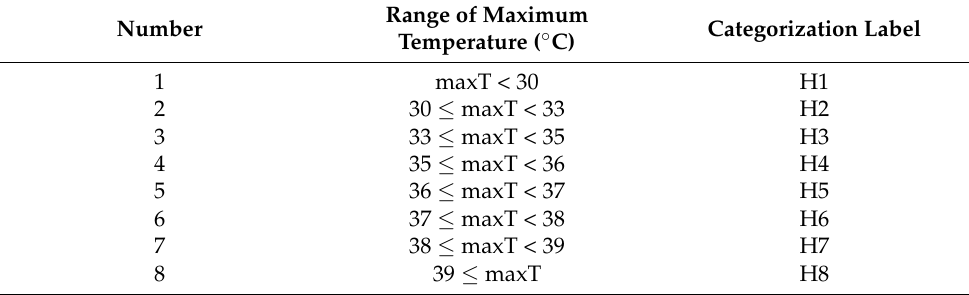
Table 3. Classification of maximum temperature (maxT).